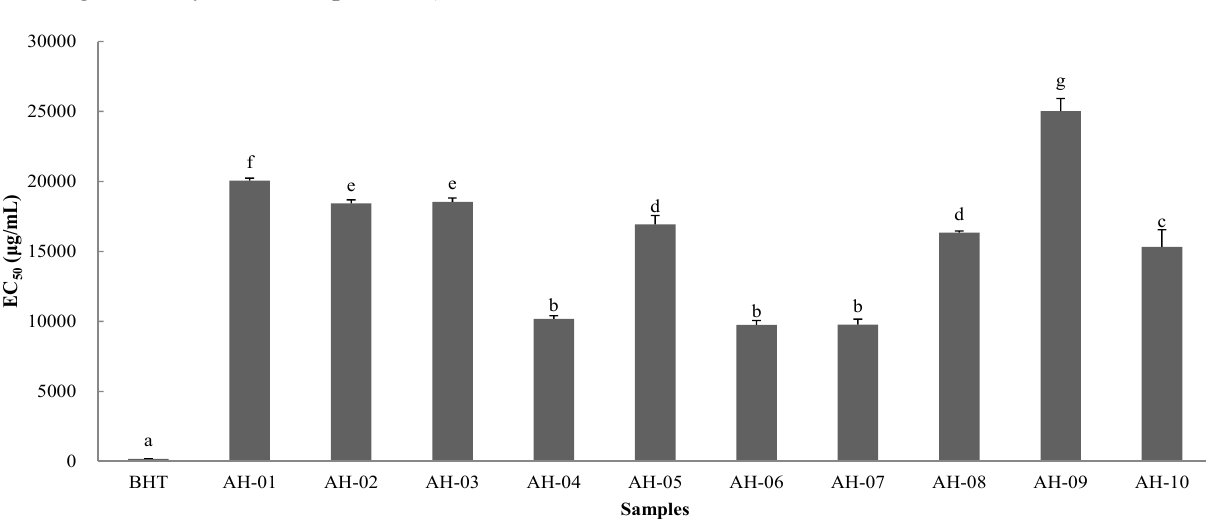
Figure 4. EC 50 values of BHT and AH samples. Values that share the same letter are not significantly different ( p <